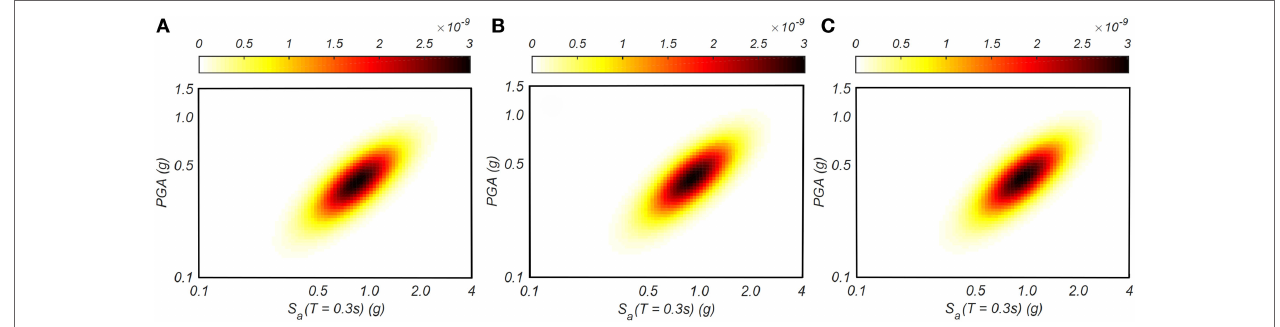
FIGURE 9 | Joint hazard curves of peak ground acceleration (PGA) and S a at (A) Point 1, (B) Point 2, and (C) Point 3.